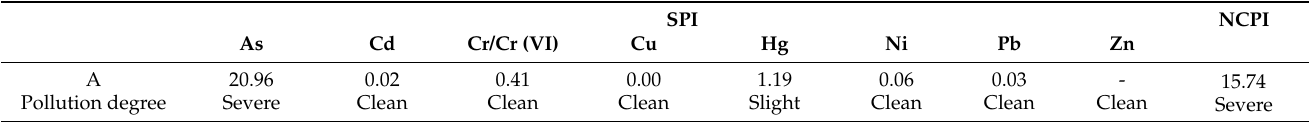
Table 9. Calculation results of the SPI and